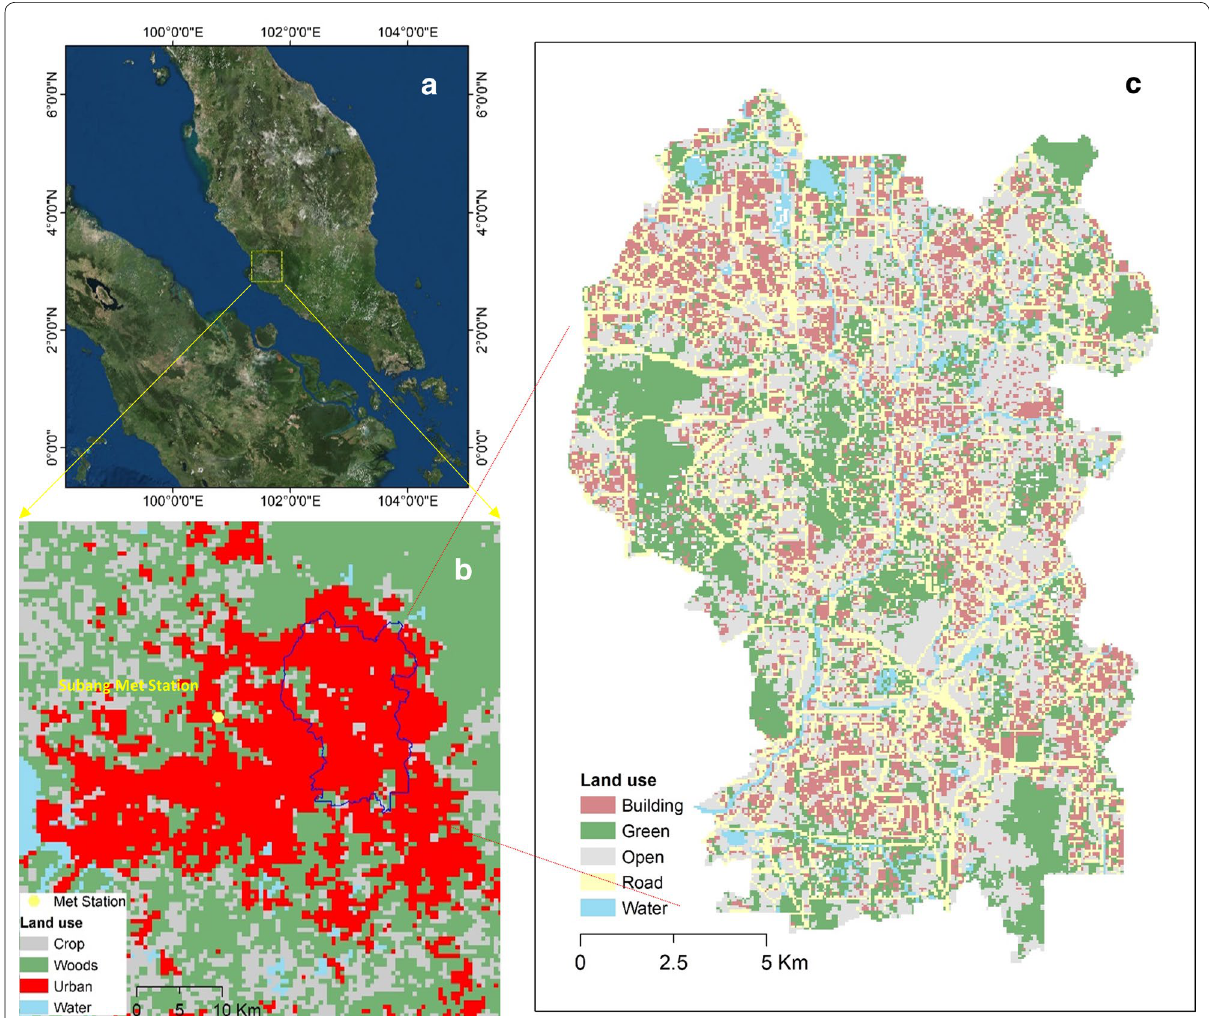
Fig. 1 a Malay Peninsula (ArcMap 10.5 base Map), b Greater Kuala Lumpur land‑use categorisation and c Kuala Lumpur city land‑use categorisation in further